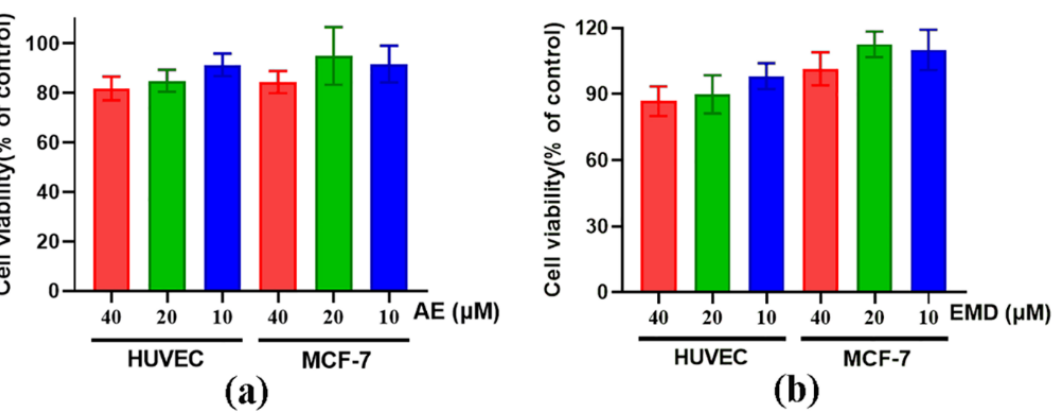
Figure 3. The cytotoxicity of AE ( a ) and EMD ( b ) at different concentrations (40, 20, 10 μM) on HUVEC and MCF-7 cells.